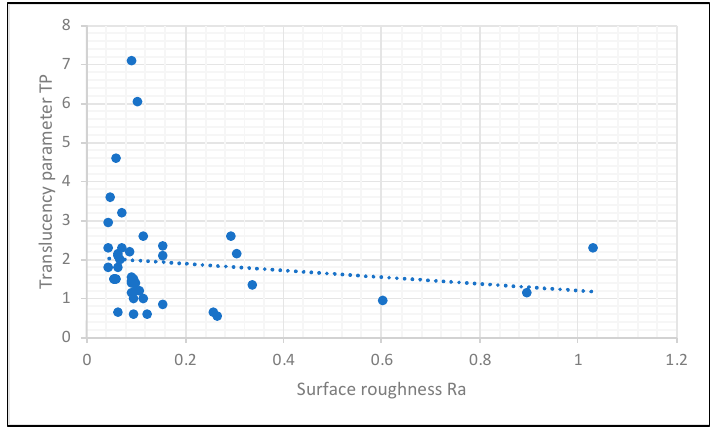
Figure 8. Correlation between translucency parameter and surface roughness.